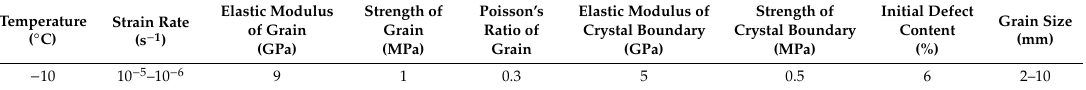
Table 1. Main parameter values of river ice in the numerical calculation.